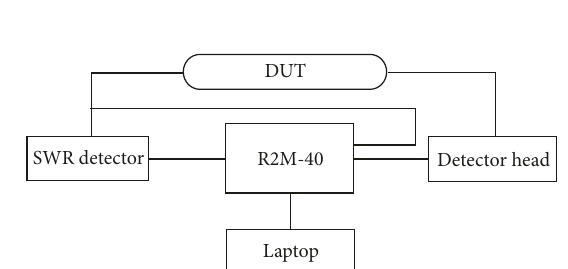
Figure 18: Schematic diagram of the experimental setup.